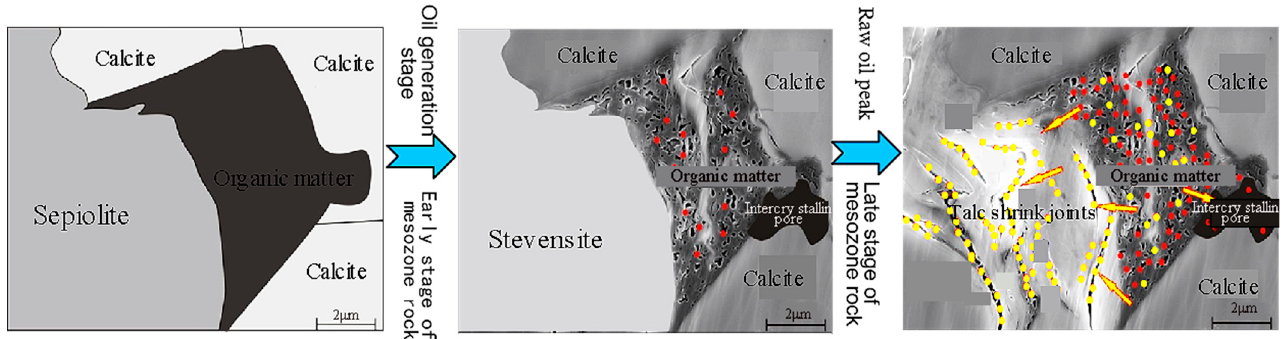
Figure 8. Diagram of the formation of organic pores and shrinkage joints in the talc transformation process.